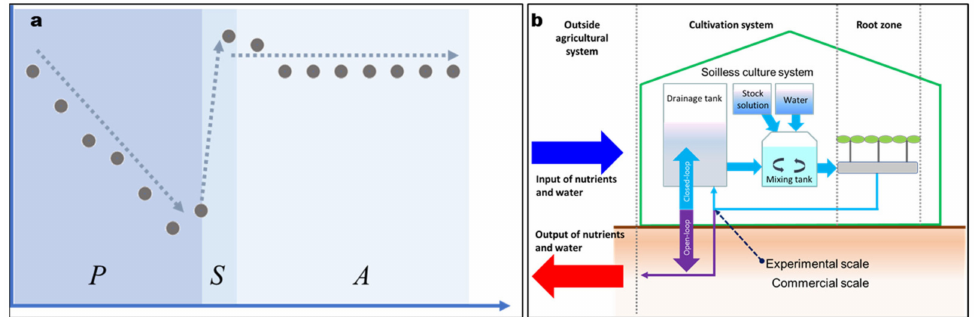
Figure 2. ( a ) Conceptual diagram of the nutrient balance control technique; P -phase: online-parameter estimation for nutrient uptake model (progress curve analysis); S -phase: short-term increment of largely decreased nutrient; A -phase: application of adjusted stock solution composition (indicates desired nutrient changes). ( b ) Schematic diagram of open- and closed-loop soilless culture systems in this